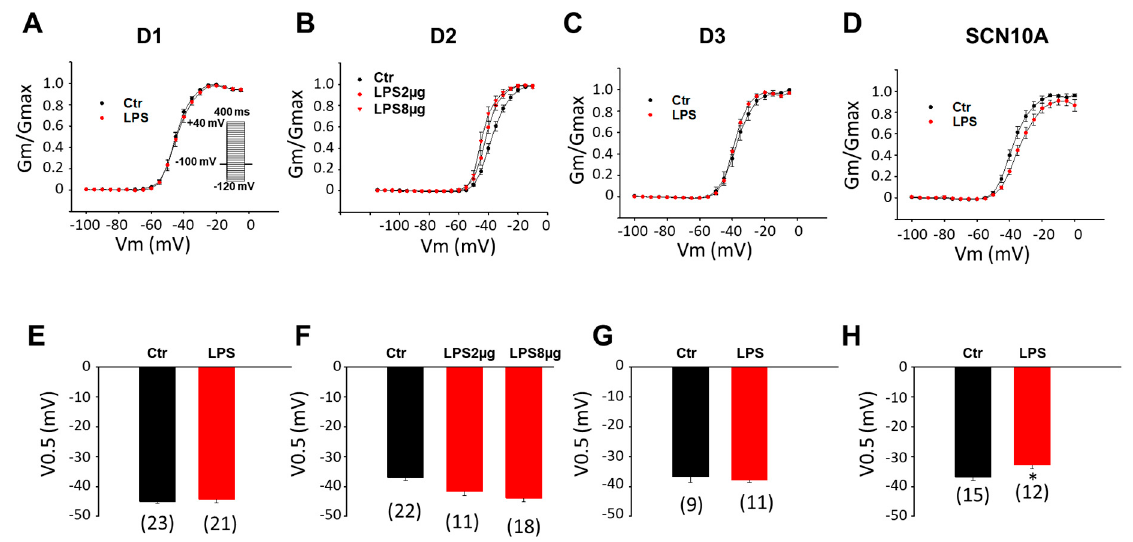
Figure 2. LPS effects on activation of sodium channels in hiPSC-CMs from healthy donors and the BrS-patient. Cells were treated with vehicle (same amount of water, Ctr) of LPS of 2 μ g/mL or 8 μ g/mL (in D2 cells) for 48 h. ( A ) Activation curves of peak sodium channel currents (I Na ) recorded in hiPSC-CMs from D1 healthy donor. ( B ) Activation curves of peak I Na recorded in hiPSC-CMs from D2 healthy donor. ( C ) Activation curves of peak I Na recorded in hiPSC-CMs from D3 healthy donor. ( D ) Activation curves of peak sodium channel currents (I Na ) recorded in SCN10A-hiPSC- CMs. ( E ) Mean values of potential at 50% activation (V0.5) in hiPSC-CMs from D1 healthy donor. ( F ) Mean values of potential at 50% activation (V0.5) in hiPSC-CMs from D2 healthy donor. ( G ) Mean values of potential at 50% activation (V0.5) in hiPSC-CMs from D3 healthy donor. ( H ) Mean values of potential at 50% activation (V0.5) in SCN10A-hiPSC-CMs. Numbers given in ( E – H ) represent the number of cells of measurements also for ( A – D ). * p < 0.05 versus Ctr according to t